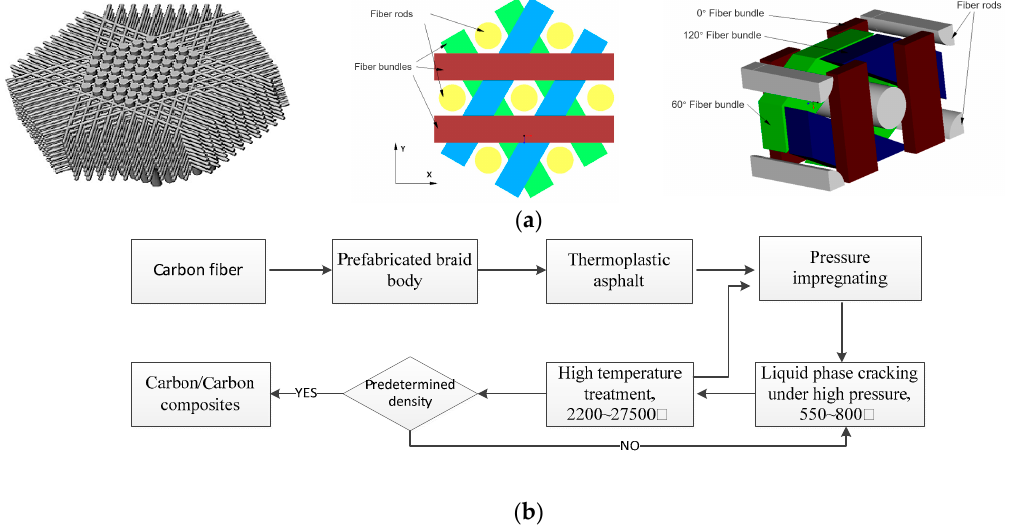
Figure 1. The braided form and manufacturing procedure of axially braided C / C composite material ( a ) the braided form of axially braided C/C composite material . The intersecting directions of the fiber rod and fiber bundle are shown in the figure; ( b ) the manufacturing procedure of axially braided C/C composite material.